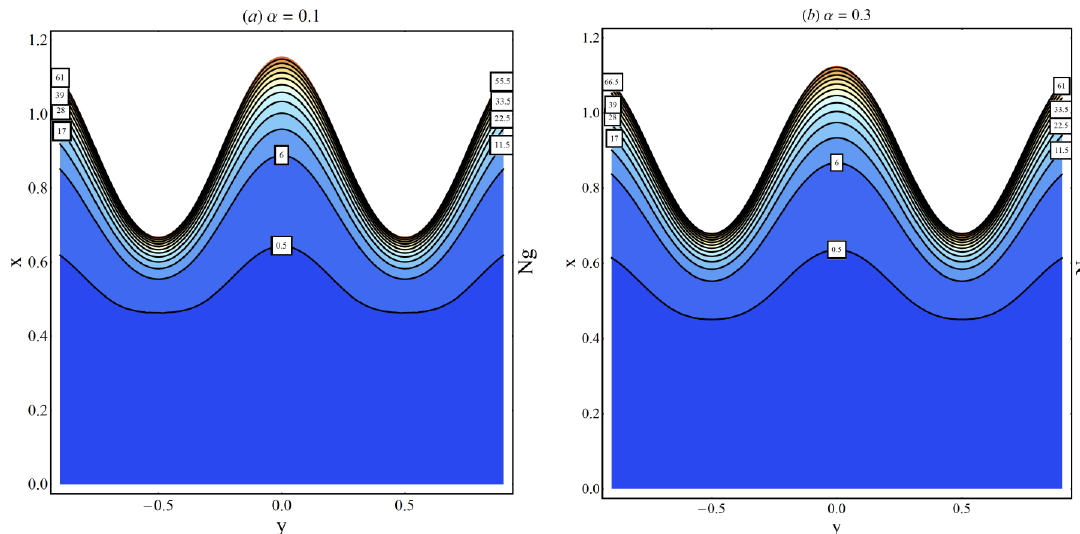
Figure 12. Entropy lines at two different α values : (a) α = 0.1 and (b) α = 0.3.